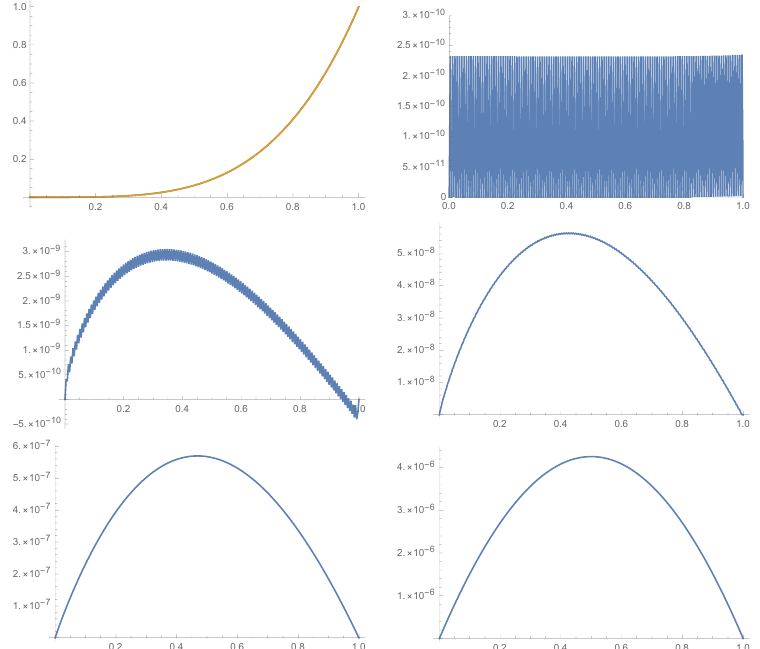
Figure 4. The analytical solution y and the numerical solutions y h , n for different value of γ ( left top panel ). The approximation error e h ,3 for γ = 1 ( right top panel ), γ = 1.25 ( left middle panel ), γ = 1.5 ( right middle panel ), γ = 1.75 ( left bottom panel ), γ = 2 ( right bottom panel